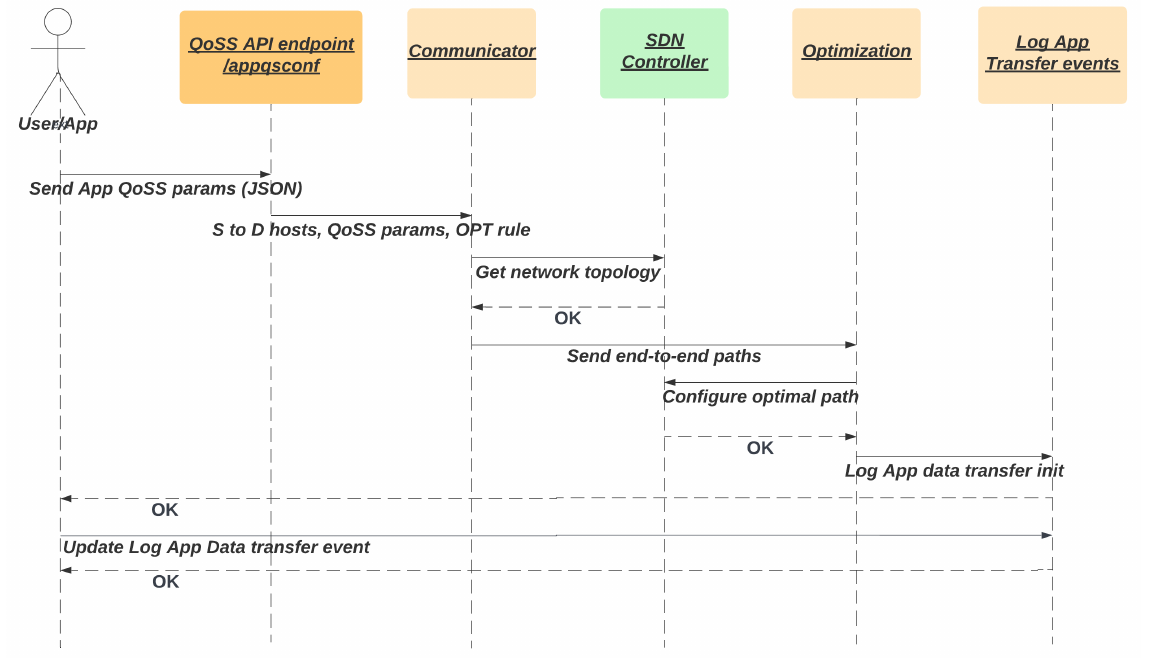
Figure 4. QoSS API general sequence diagram.